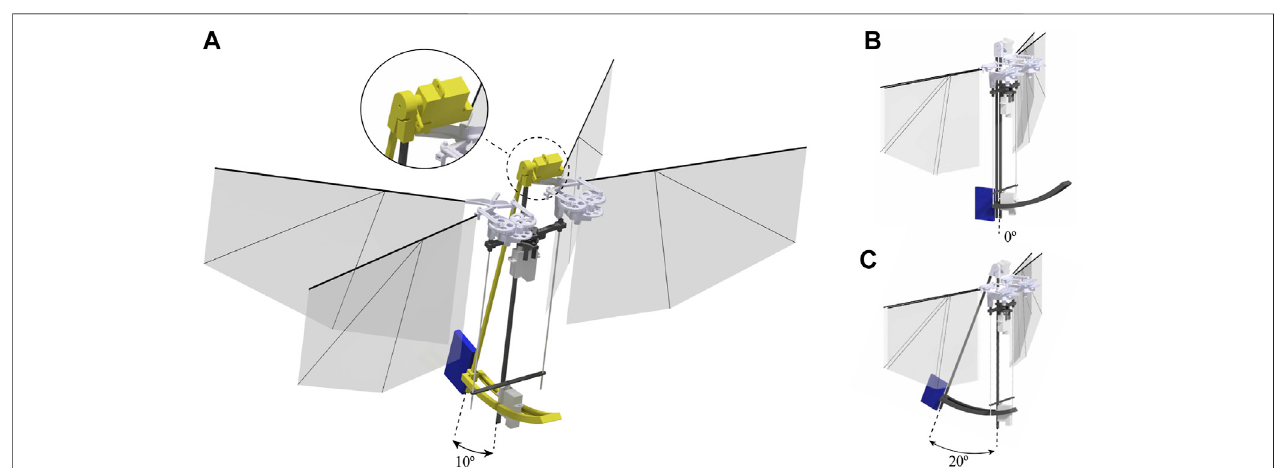
FIGURE 6 | Mass displacement mechanism (colored in yellow) of the asymmetric fl apping wing MAV allows setting the desired displacement angle from 0 to 20 ° . The mass displacement of 0 cm, 2 cm, and 4 cm is corresponding to displacement angle of the mechanism of (B) 0 ° (A) 10 ° (C) 20 ° accordingly. The battery is accounting for 17% of the mass and is marked in blue.